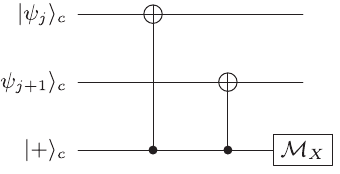
FIG. 5. Joint-parity measurement between two neighboring cat qubits j and j þ 1 of a repetition cat qubit, using one ancilla cat qubit. Note that the error propagation from ancilla cat qubit to data ones is exponentially suppressed by the cat size.